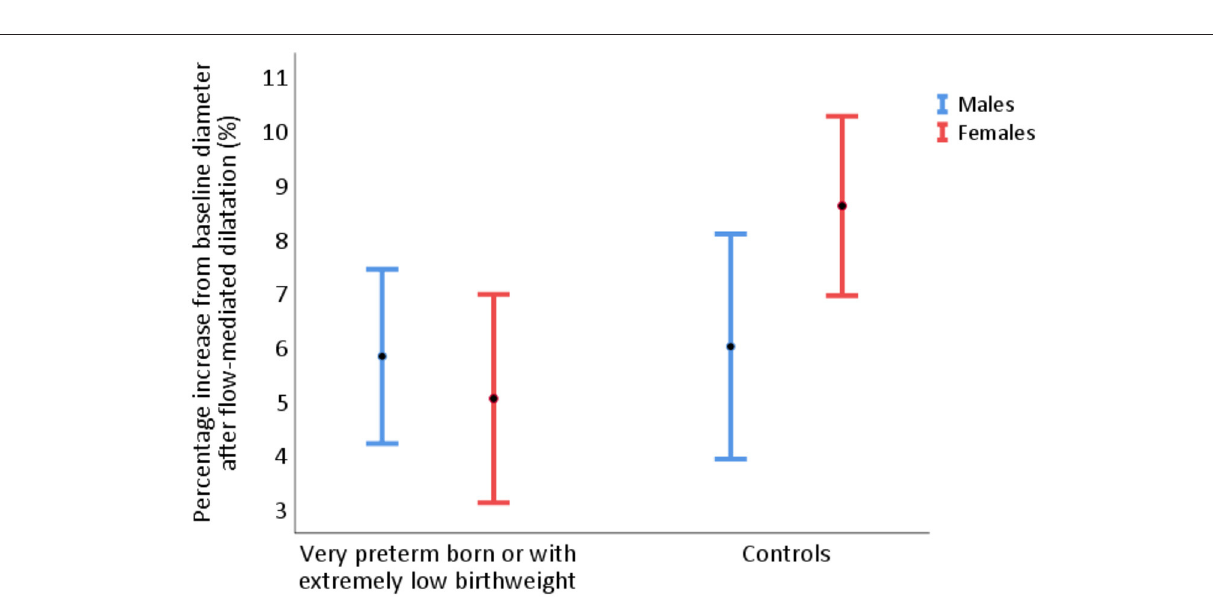
FIGURE 7 | Percentage flow-mediated dilatation (FMD) of the brachial artery in 24 men and 26 women born very preterm or with extremely low birthweight, and term-born controls (20 men and 29 women), presented as mean with 95% CI. In women, percentage FMD was 5.0% (95% CI 3.1, 7.0) for PB/ELBW vs. 8.6% (95% CI 7.0, 10.3) for controls. In men, percentage FMD was 5.8% (95% CI 4.2, 7.4) for PB/ELBW vs. 6.0% (95% CI 3.9, 8.1) for